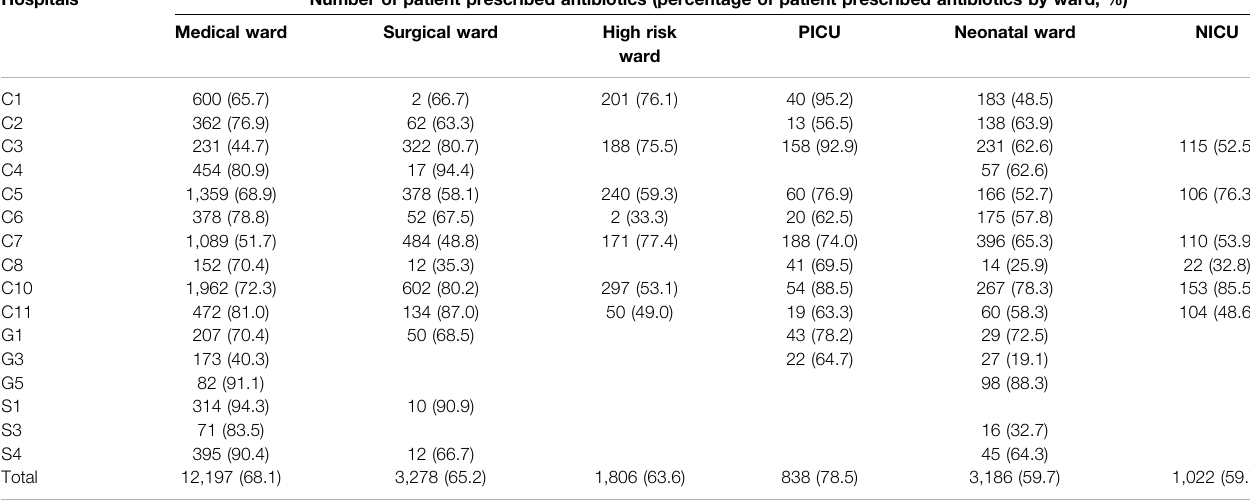
TABLE 4 | Antibiotic prescribing pattern by different ward types.